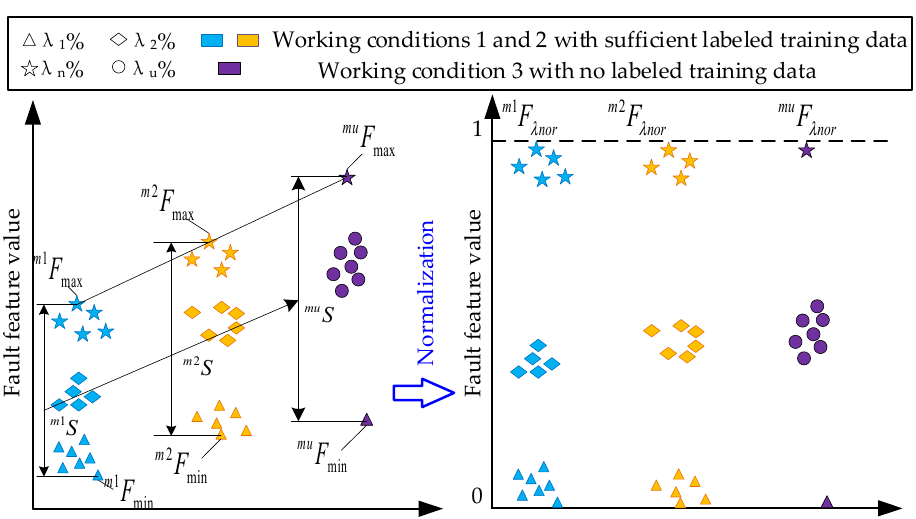
Figure 7. The schematic diagram of LSP.